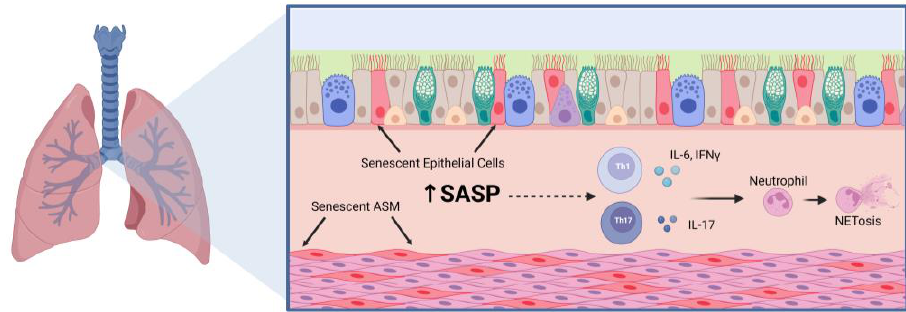
Figure 1. Notable Inflammatory Mechanisms in the Aged Asthmatic Lung. The aged asthmatic airway has persistent airway inflammation that includes increased senescent epithelial and airway smooth muscle (ASM) cells, which secrete pro-inflammatory and pro-fibrotic factors that contribute to airway inflammation. The senescence-associated secretory phenotype (SASP) can include IL- 1β, IL-6, IL- 8, TNFα, matrix metalloproteinases, and extracellular matrix proteins such as fibronectin and collagen. Among these inflammatory mediators are cytokines that are known to promote T helper (Th) 1 and Th17 cell differentiation and effector functions which can promote neutrophil infiltration and activation. Figure was created using BioRender.com accessed on 7 March 2023.